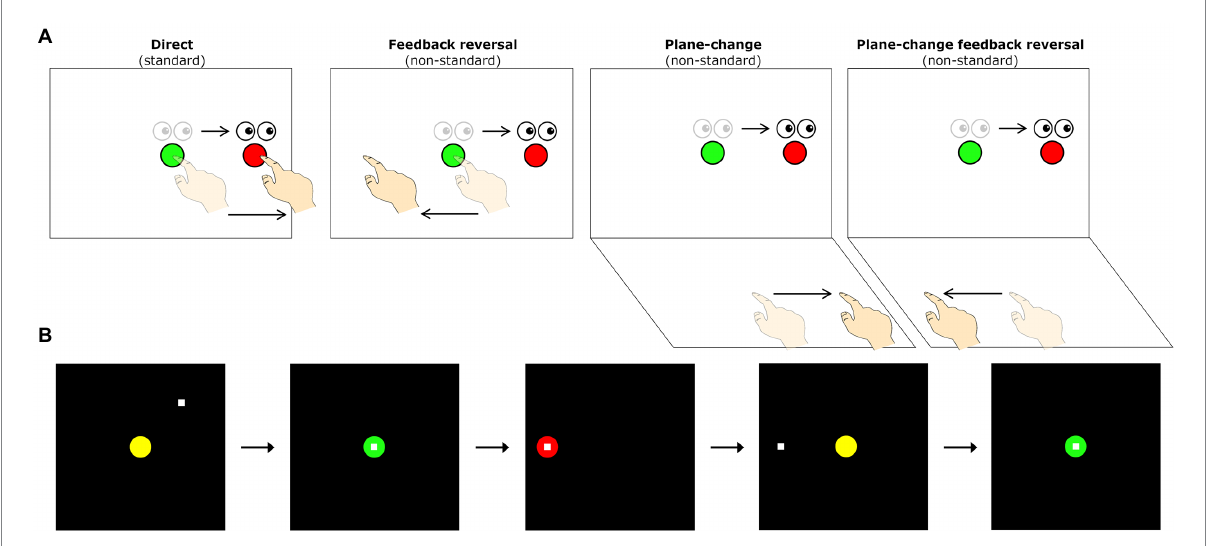
FIGURE 1 (A) Schematic drawing of the visuomotor task conditions. Lighter eye and hand symbols denote the starting position for each trial (green central target). Darker eye and hand symbols denote the instructed eye and hand movements for each task. Red circles denote the peripheral (reach) target, presented randomly in one of four locations (left, up, right, or down relative to the central target). The direct interaction task requires standard mapping, where participants slide their finger on a touch screen to move a cursor from a central target to one of four peripheral targets. The other three conditions involve non-standard visuomotor integration, where targets either have a 180 ° feedback reversal (feedback reversal), are spatially dissociated from the plane of hand motion (plane-change), or both (plane-change + feedback reversal). (B) Sequence of events during one trial of the visuomotor task. All trials begin in the central (home) target. Once the participant moves the cursor (denoted by the white square) into the central target, the target changes from yellow to green to signify a movement preparation period. After 4,000 ms, a red peripheral target appears in one of four directions (up, down, left, or right of the center) and serves as the ‘Go’ signal. Once the peripheral target is acquired and held for 500 ms it disappears, signaling the end of the trial. After an inter-trial interval of 2000 ms, the central yellow target reappears, and the participant moves back to the central target to initiate the next